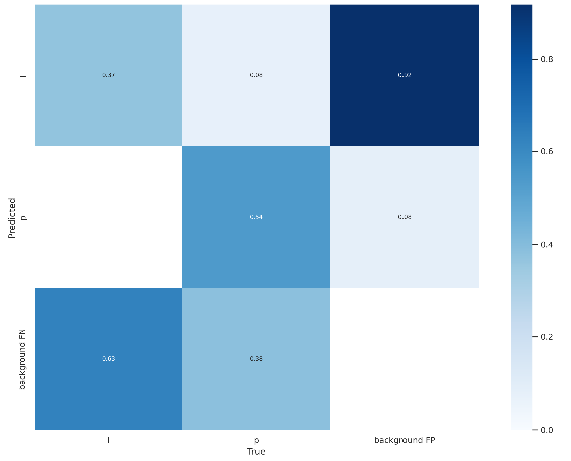
Table 3: Results achieved in the classification of vegetation strata from dashcam videoframes